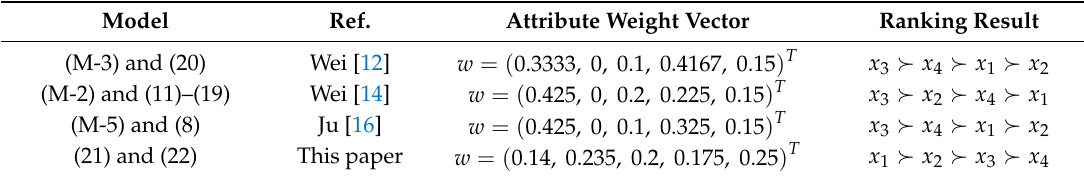
Table 8. A comparative study for attribute weight vectors and ranking results obtained from different